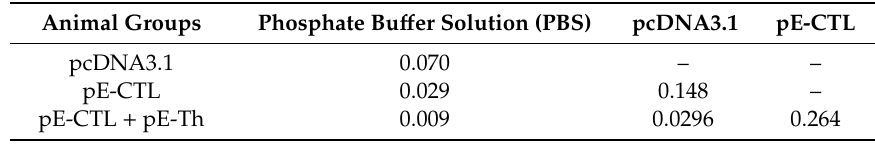
Figure 4. The results of IFN γ -producing T-cell count in IFN γ -ELISpot assay in BALB / c mice immunized with DNA-vaccine constructs encoding target immunogens (n = 6 for phosphate bu ff er solution (PBS) control group and n = 10 for the other groups). The figure represents spot count (i.e., IFN γ -producing T-cells) in di ff erent experimental and control animal groups. Table 3. Results of statistical data analysis in ELISpot.